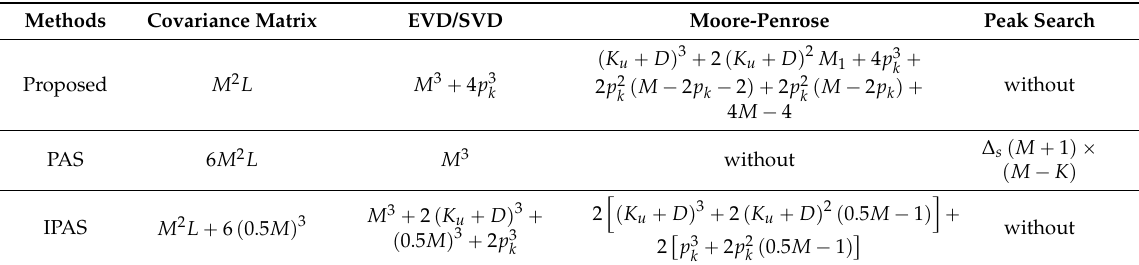
Table 3. Comparison of computational complexity of three